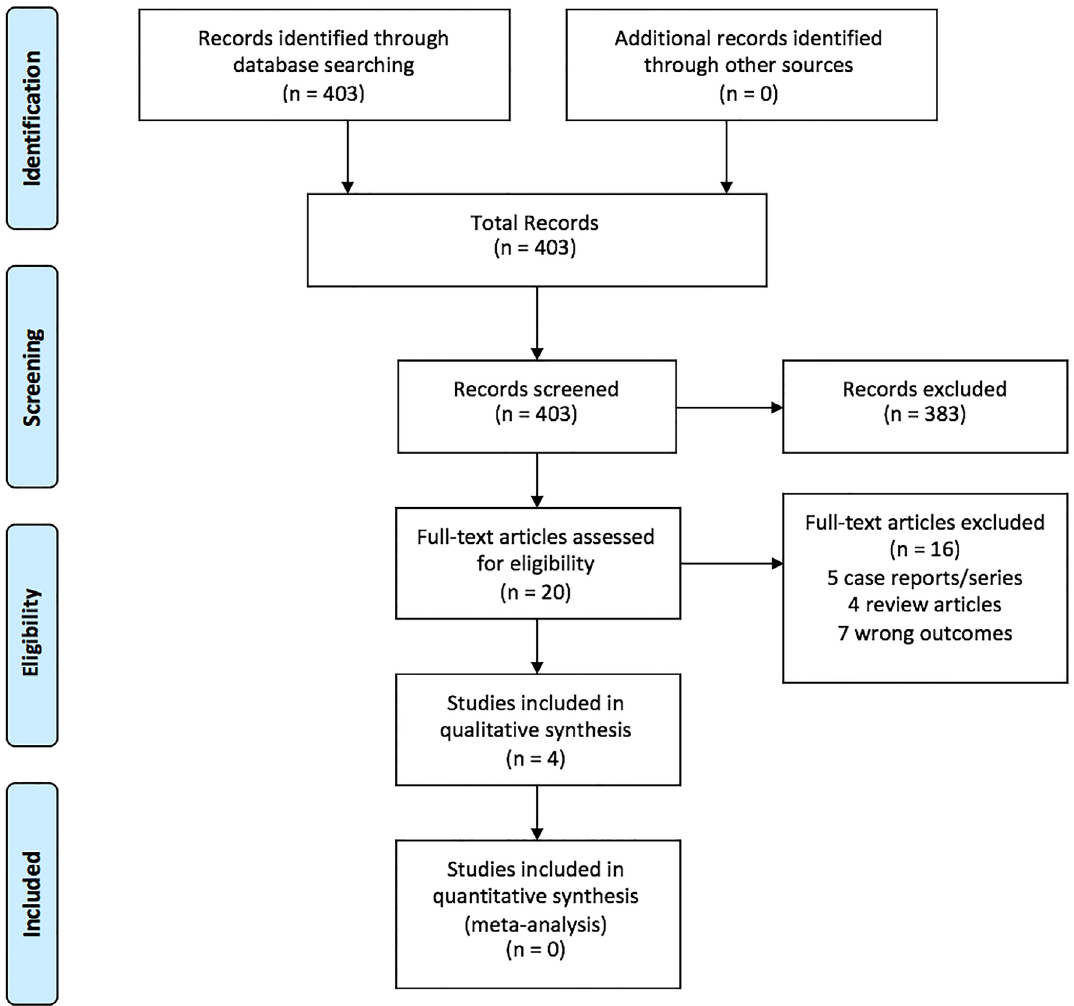
Figure. Outline of study selection and